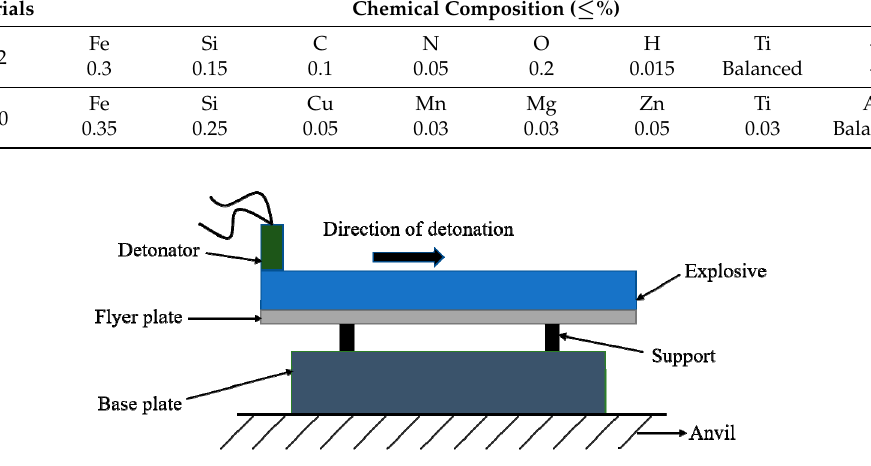
Figure 1. Parallel display of experimental set-up for explosive welding.